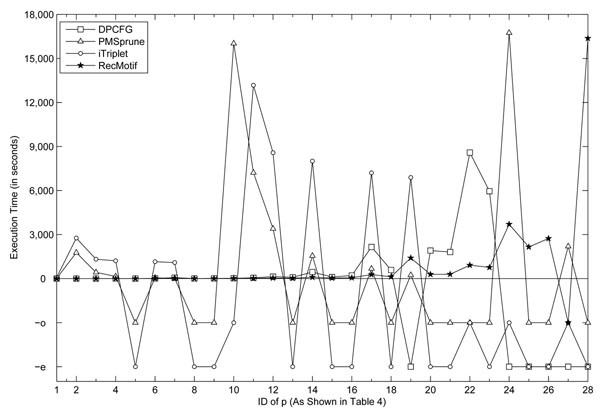
Effects of increasing p (with related (l, d)) on execution time This figure shows how the execution times of algorithms, including PMSprune, iTriplet, DPCFG and RecMotif, change with the parameter p.